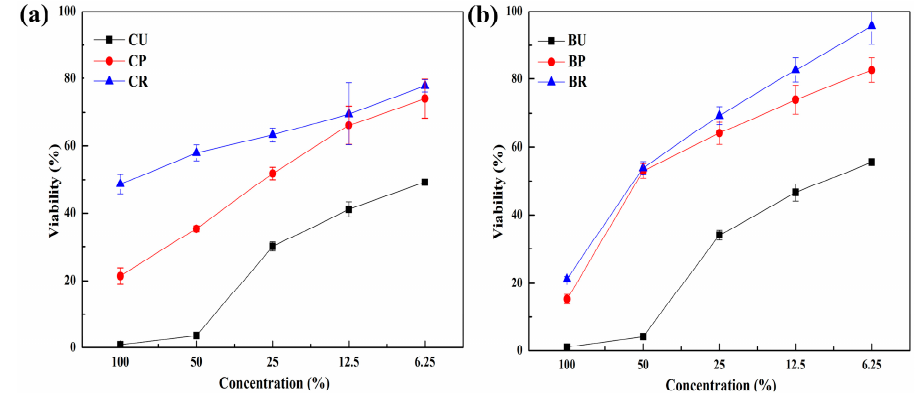
Figure 3. Cell viability following exposure to the extracts from ( a ) composite resin and ( b ) bonding resin at different dilutions. B: bonding resin; C: composite resin; U: uncured; P: post-cured; R: unreacted layer removed.